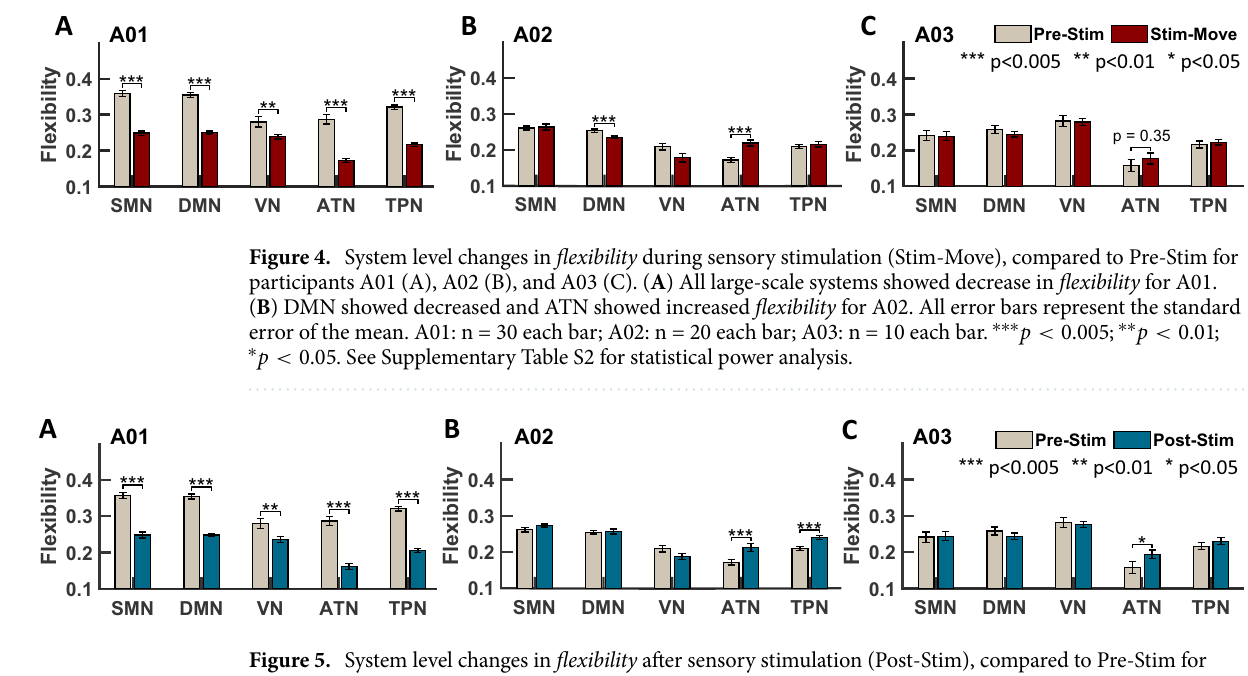
Figure 5. System level changes in flexibility after sensory stimulation (Post-Stim), compared to Pre-Stim for participants A01 (A), A02 (B), and A03 (C). ( A ) All large-scale systems showed decrease in flexibility for A01. ( B ) ATN and TPN showed increased flexibility for A02. ( C ) ATN showed increase in flexibility for A03. All error bars represent the standard error of the mean. A01: n = 30 each bar; A02: n = 20 each bar; A03: n = 10 each bar. ∗∗∗ p < 0.005 ∗∗ p < 0.01 ∗ p < 0.05 ; ; . See Supplementary Table S2 for statistical power